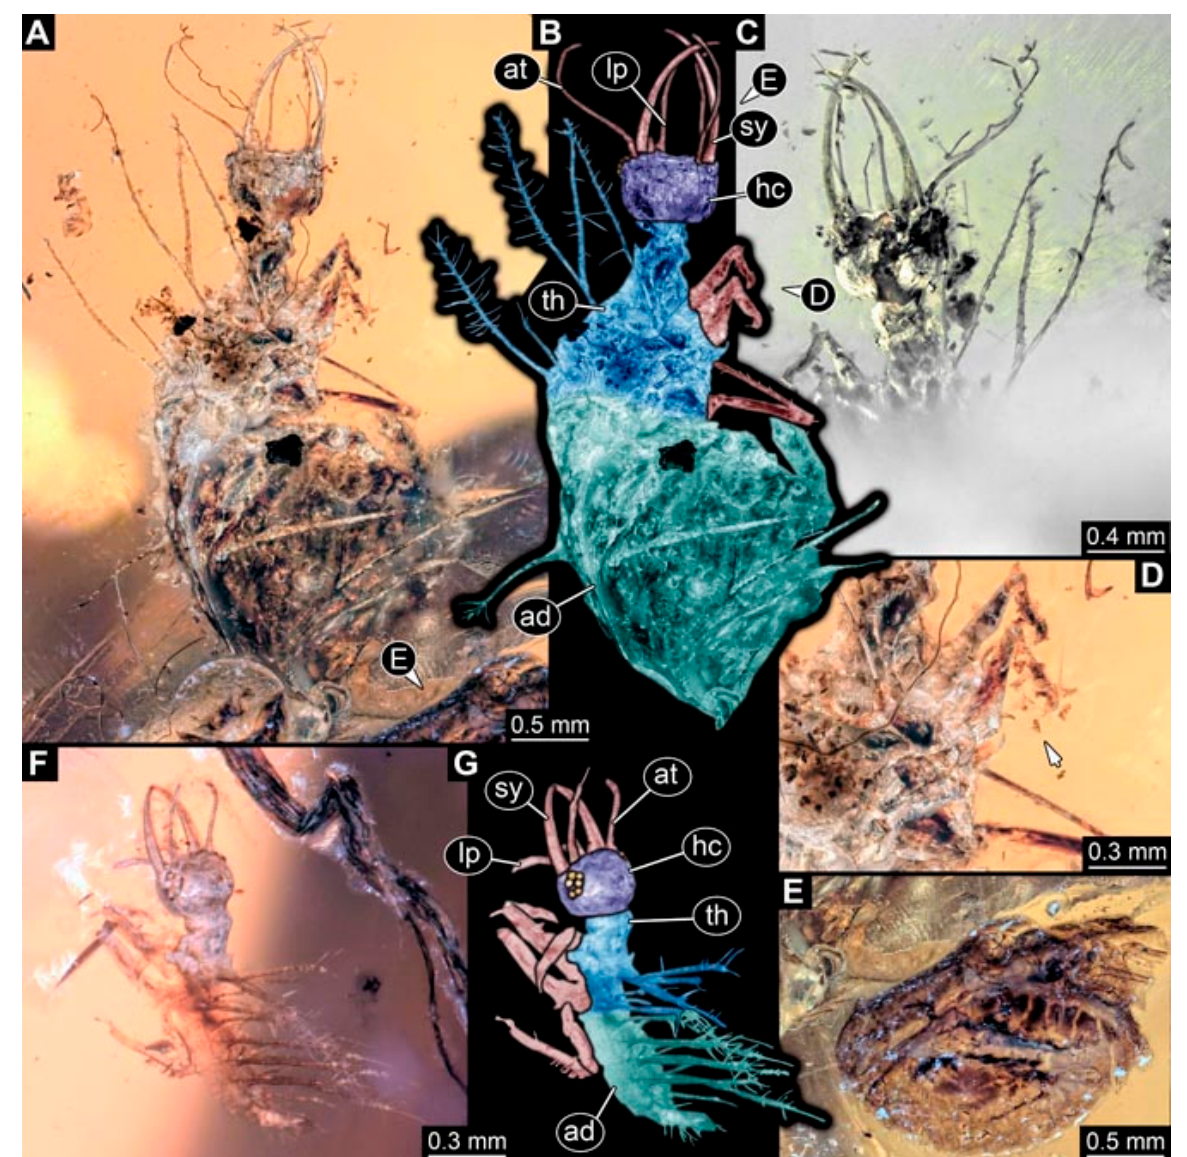
Figure 36. Two specimens in Myanmar amber. ( A – E ) Specimen 4861 (PED 0989a). ( A ) Dorsal view. ( B ) Dorsal view, colour-marked. ( C ) Close-up of head capsule in ventral view. ( D ) Close-up of trunk appendages with empodium (arrow). ( E ) Possible exuvia, or other remain. ( F – G ) Specimen 4862 (PED 0989b). ( F ) Dorsal view. ( G ) Dorsal view, colour-marked. Abbreviations: ad = abdomen; at = antenna; hc = head capsule; lp = labial palp; sy = stylet; th = thorax.